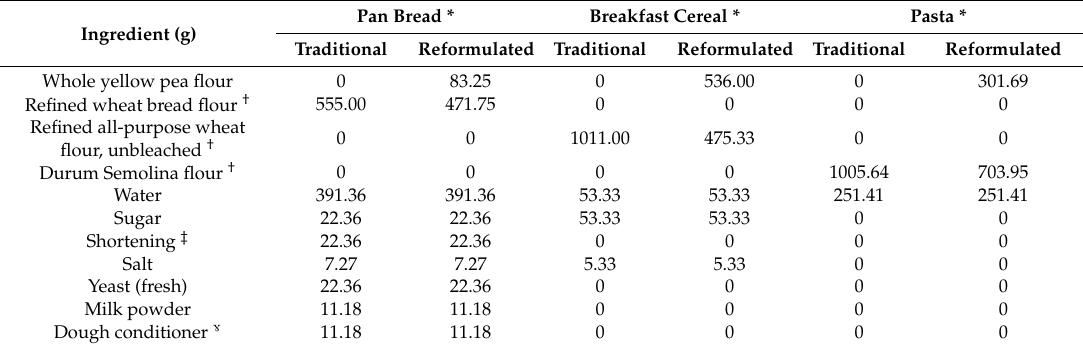
* Ingredient formulations for reformulated pan bread, breakfast cereal, and pasta were provided by from the Canadian International Grains Institute. All of the flour in traditional formulations was from refined wheat flour. In reformulated foods, a proportion of the total flour was whole yellow pea flour (pan bread: 15%; breakfast cereal: 53%; pasta: 30%). † Refined wheat bread flour: 12.5–13.5% protein dry weight; refined wheat all-purpose